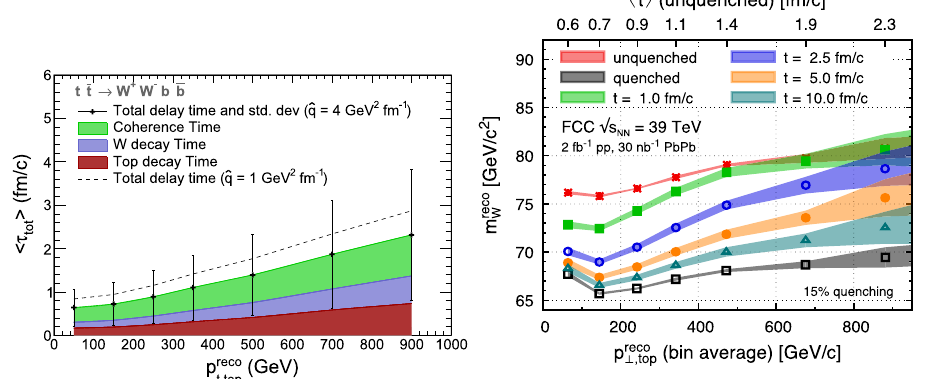
corresponds to a ˆ q = 1 GeV 2 / fm. Right: reconstructed W boson mass, as a function of the top p T . The upper axis refers to the average total time delay of the corresponding top p T bin